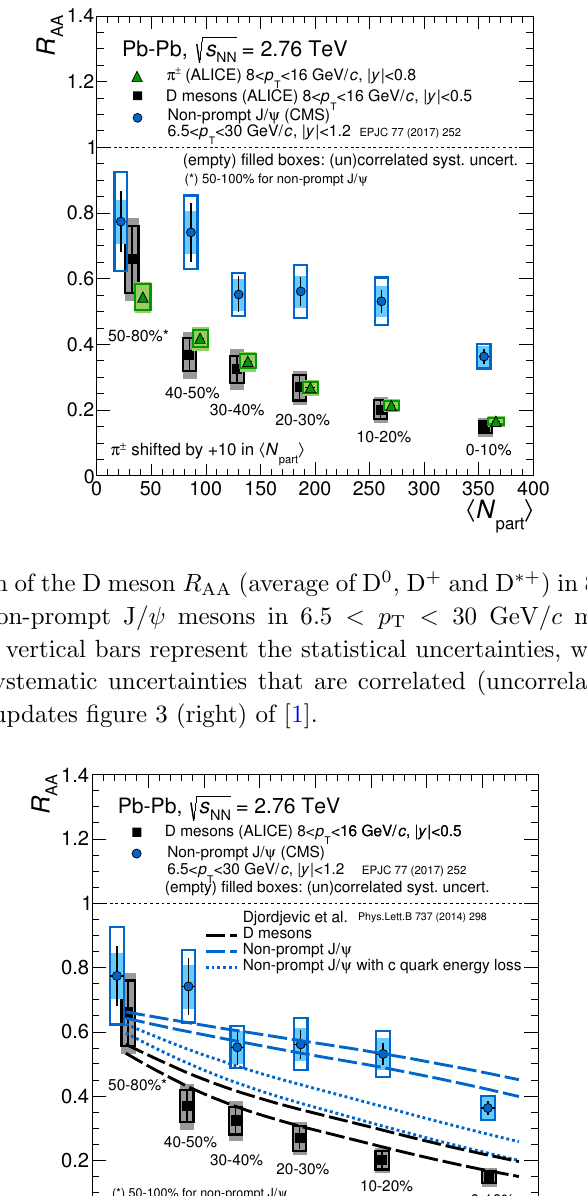
calculations [4{6], as originally done in